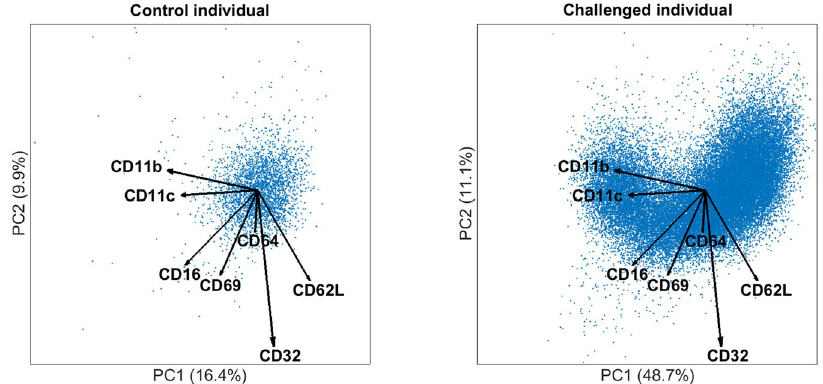
Figure 1. Shows a biplot of the cells of a typical control (left) and a typical LPS-responding individual (right). Each dot represents a score, thus a single cell. The model loadings are represented by vectors and indicate how each surface marker contributes to the cell variability in a specific direction. The percentage given is the explained variance per PC of that individual.